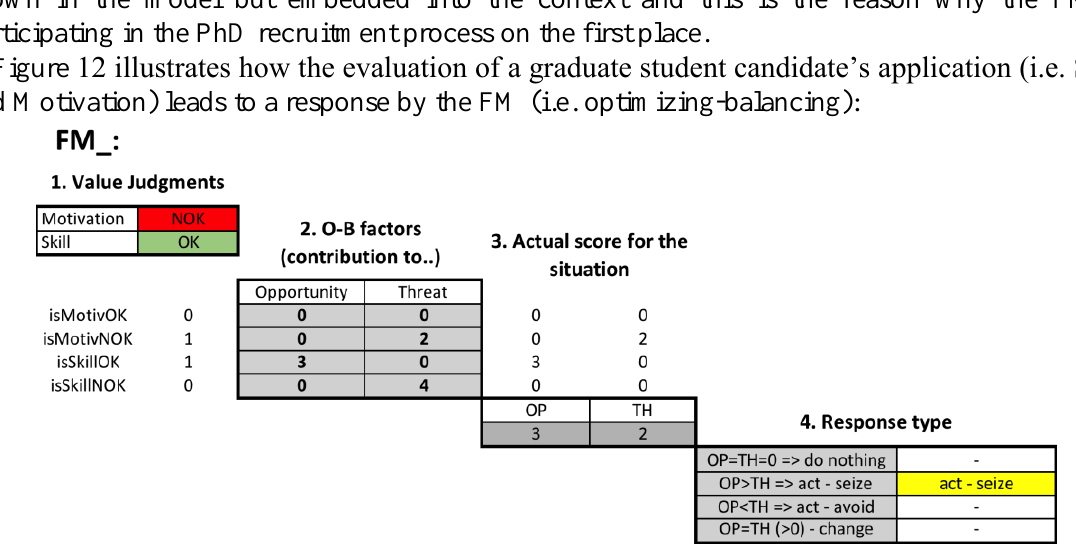
Figure 12. Optimizing – balancing for the appreciation statechart of the